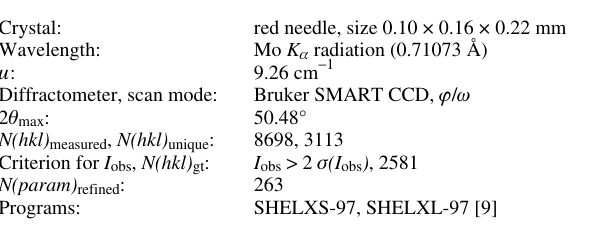
Table 1. Data collection and handling.